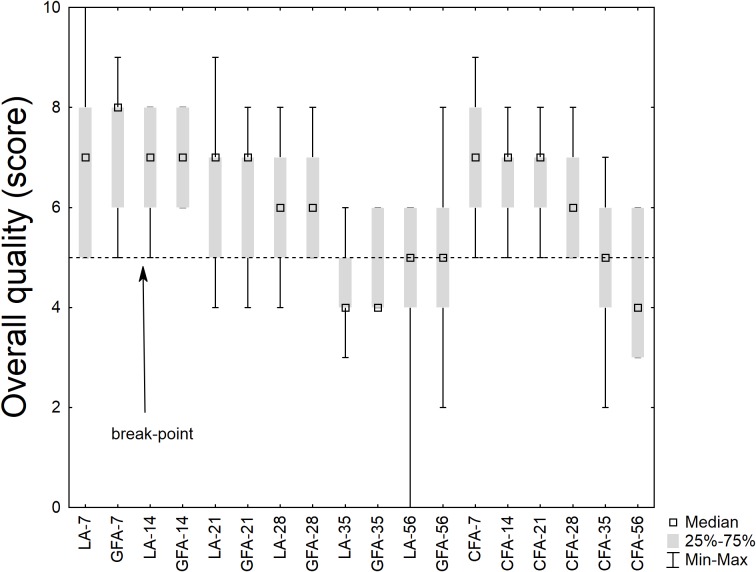
Box-whisker plot on the sensory score (overall quality). LA, product with L. acidophilus; GFA, product with L. acidophilus and Gluten Friendly flour; and CFA, product with L. acidophilus and control flour. The numbers after the acronym of the samples indicate the days of storage (analysis after 7, 14, 21, 28, 35, and 56 days).